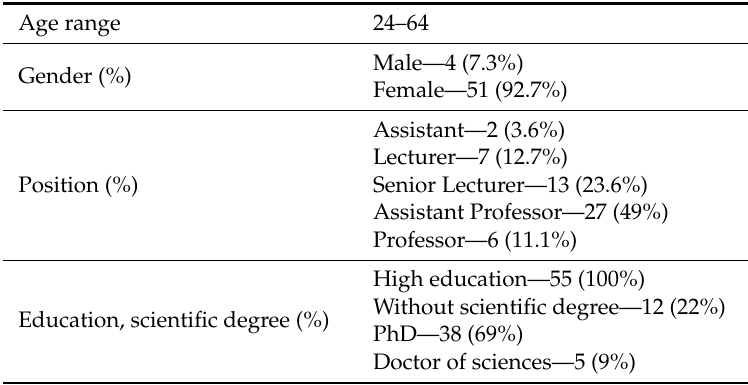
Figure 2. To what educational level should you apply research-based training elements (bachelor only, master only, both)? The third question of the survey (What motivates you to apply research-based training elements? (estimate each of the proposed variants on the scale)) was the most controversial and made it possible to understand the opinions of the staff of the Institute of Human Sciences regarding the effectiveness of the application of research-based training elements, their readiness for the implementation of this type of training and their motivation in the process of implementing changes in Ukraine’s higher education system (see Table 4).